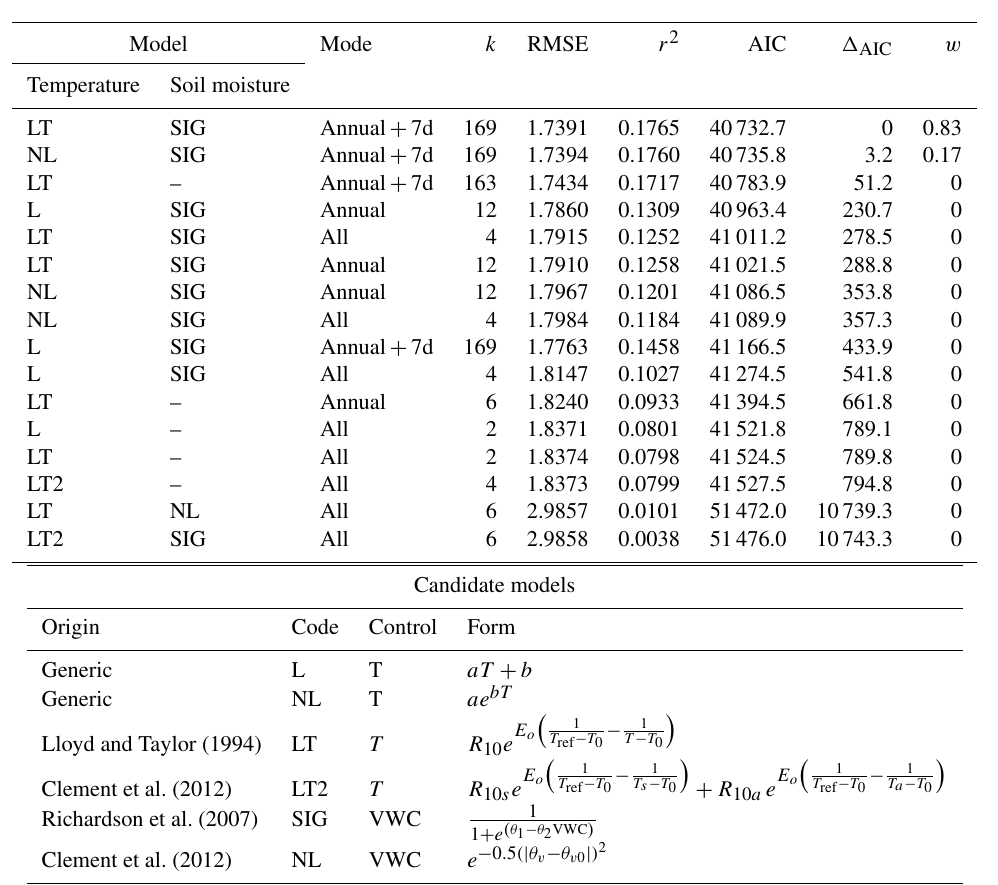
Table 3. Statistical ranking of candidate models for ER estimation (mode refers to the temporal fitting method, k is the number of parameters, RMSE is root mean square error, r 2 is coefficient of determination, AIC is Akaike’s information criterion, (cid:49) AIC is the AIC difference relative to the best candidate, and w is Akaike weight. Note that additional candidate models were tested but were excluded if parameter estimation